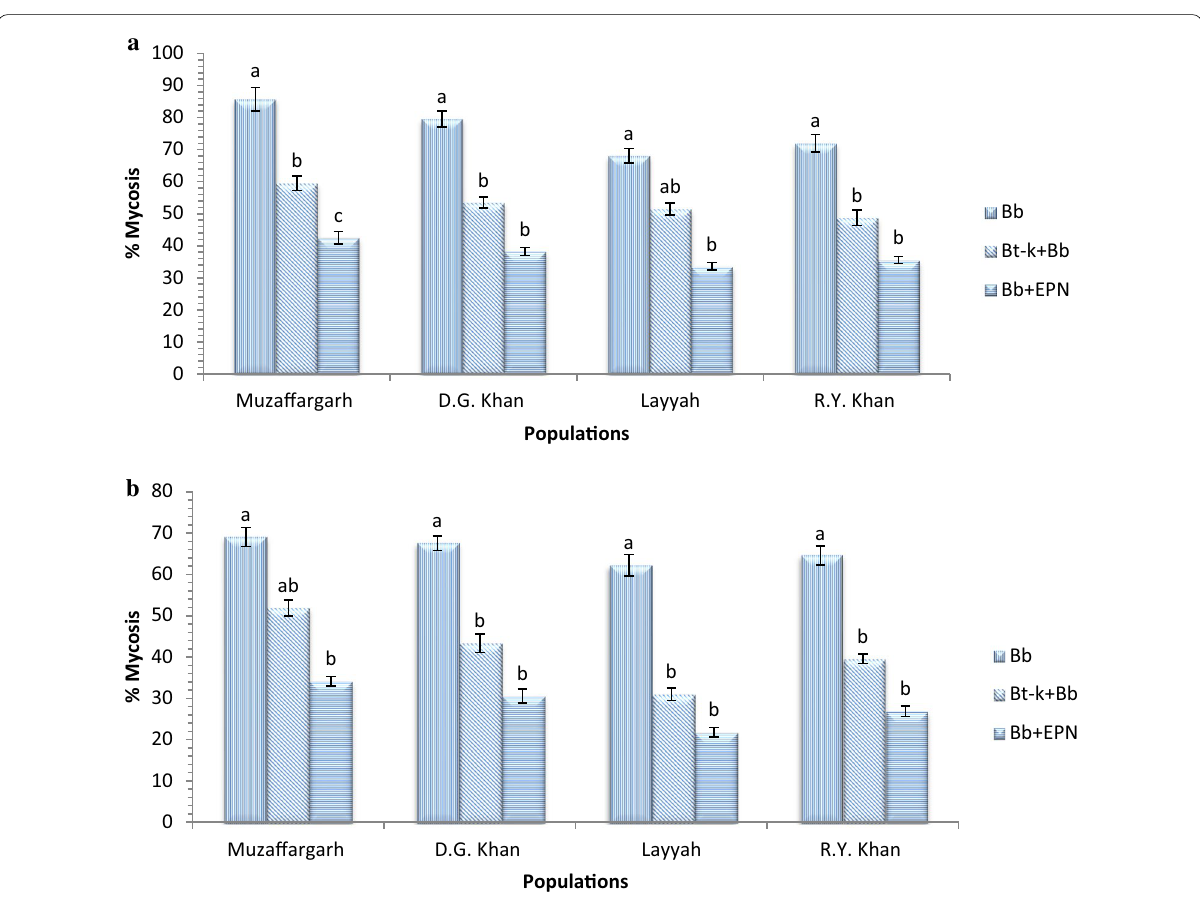
Fig. 1 a Mycosis percentage in Rhynchophorus ferrugineus larvae treated with Bt-k (70 µg g − 1 ), Beauveria bassiana (1 Heterorhabditis bacteriophora (300 IJs ml − 1 ) applied alone or in combination. Percentage mycosis followed by the same letter within each treatment are not significantly different; HSD test P 0.05 (( Bt-k : Bacillus thuringiensis var. kurstaki , Bb: Beauveria bassiana , EPN: Heterorhabditis bacteriophora ). b ≤ Mycosis percentage in Rhynchophorus ferrugineus adults treated with Bt-k (70 µg g − 1 ), Beauveria bassiana (1 bacteriophora (300 IJs ml − 1 ) applied alone or in combination. Percentage mycosis followed by the same letter within each treatment are not significantly different; HSD test P 0.05 ( Bt-k : Bacillus thuringiensis var. kurstaki , Bb: Beauveria bassiana , EPN: Heterorhabditis bacteriophora ≤